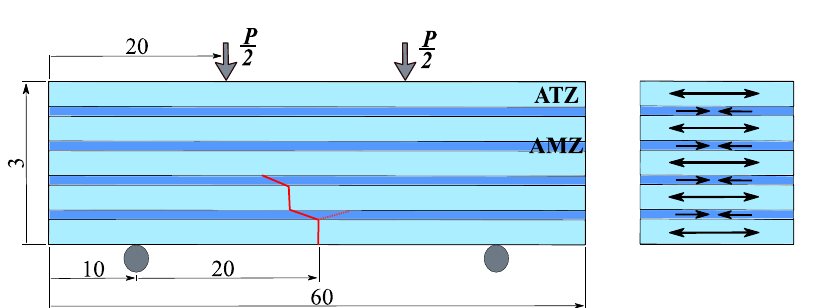
Figure 2: Scheme of studied ceramic laminate with typical crack path (dimensions in [mm]) and orientation of residual stresses in composite layers.